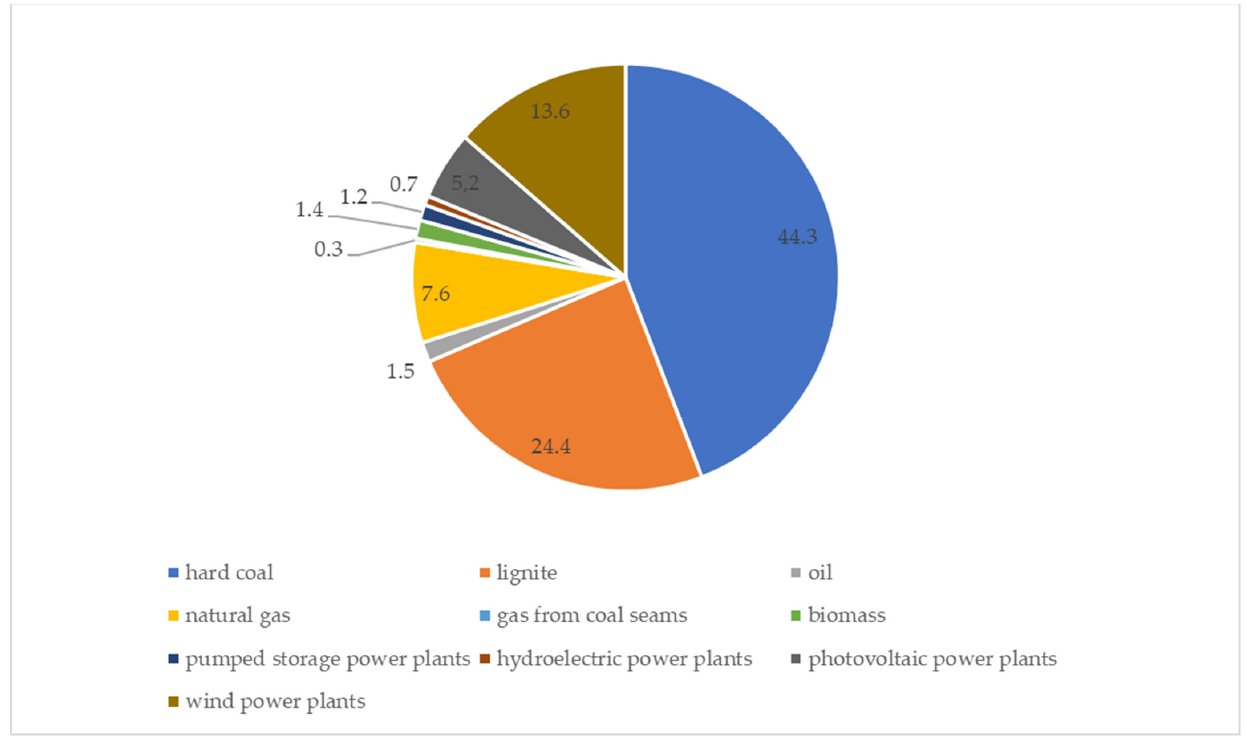
Figure 6. Structure of electricity production sources in Poland in 2022 year (%). Source: own elaboration based on [71].